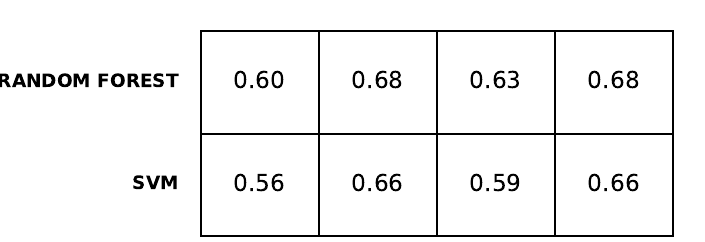
Figure 4. Results of the prediction of depression